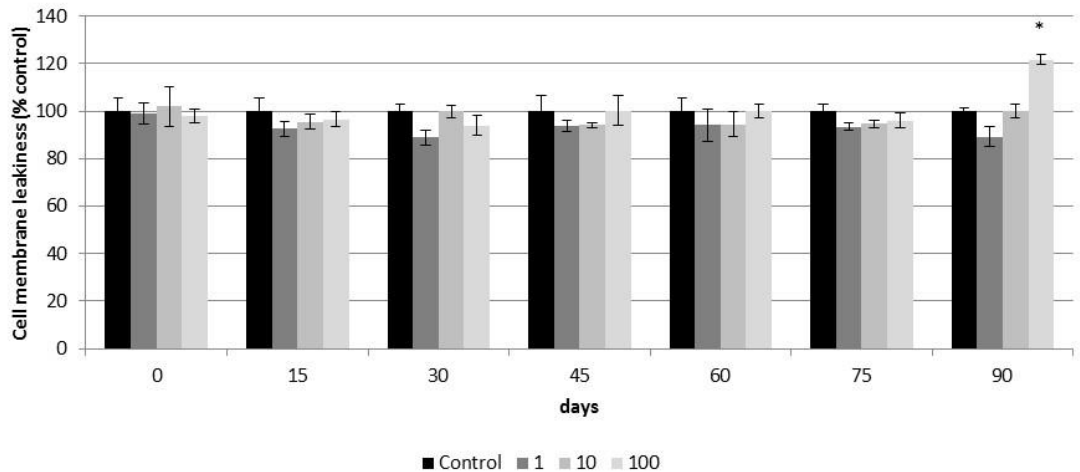
Figure 11. Cell membrane integrity (LDH test) of control airway epithelia and airway epithelia exposed for 90 days to different concentrations of CeO 2 -NPs (1, 10, and 100 µg/cm 2 ). Exposures were performed every two weeks for three months. Results are expressed as means ± SD of five replicates per tested condition and one assay ( n = 5). The asterisk indicates significant differences with respect to the untreated control cells ( p < 0.05).